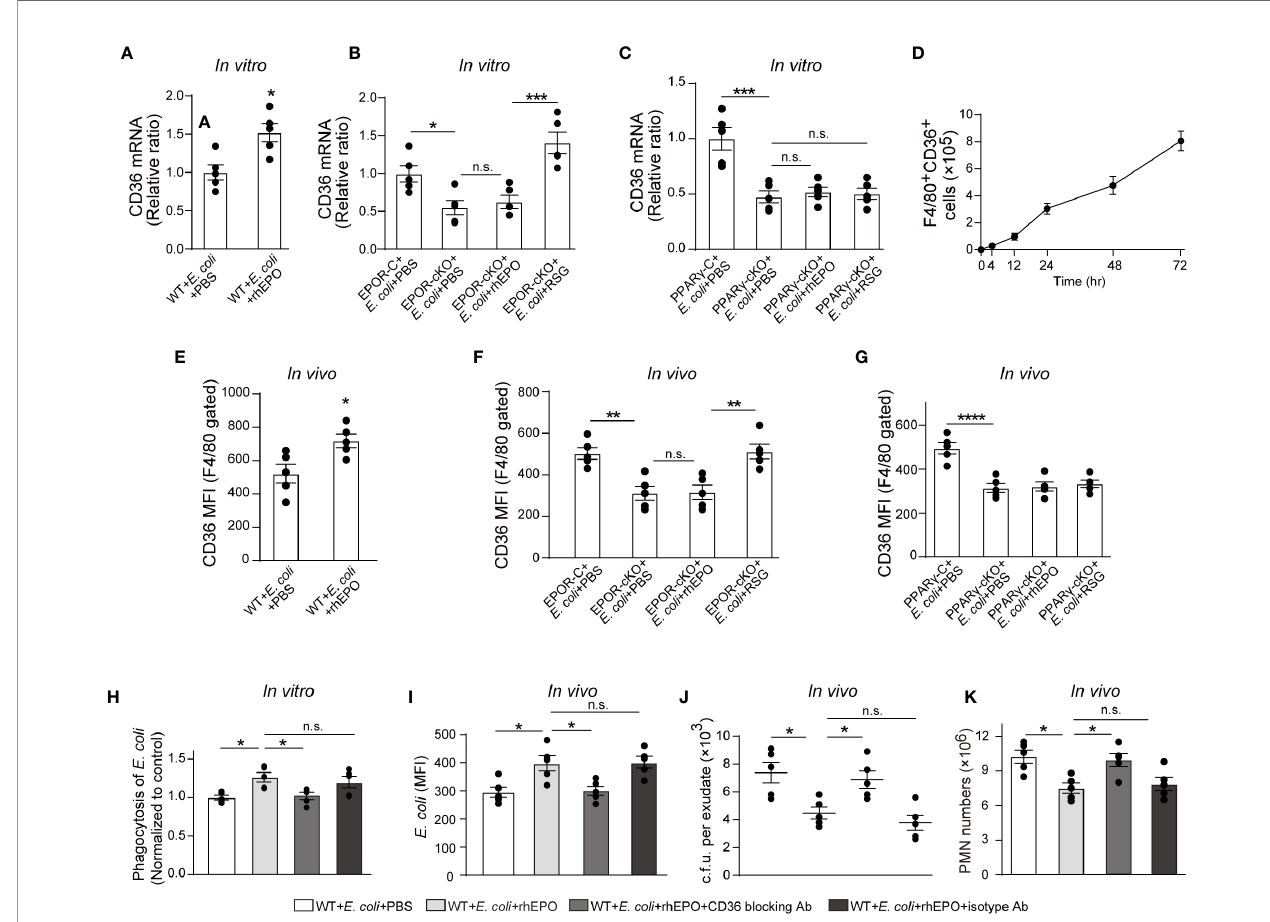
FIGURE 5 | PPAR g -induced CD36 contributes to EPO-enhanced macrophage phagocytosis of E. coli . (A) : Thioglycolate-elicited peritoneal macrophages were incubated with rhEPO (20 IU/ml) or PBS in the presence of heat deactivated E. coli (macrophage: E. coli = 1: 10) for 24 hrs. CD36 transcript levels in puri fi ed macrophages were assayed by RT-qPCR (n = 5). (B, C) : Thioglycolate-elicited peritoneal macrophages from EPOR-cKO mice (B) or PPAR g -cKO mice (C) were incubated with rhEPO (20 IU/ml, 24 hrs), RSG (10 m M, 48 hrs) or PBS in the presence of heat deactivated E. coli (macrophage: E. coli = 1: 10, 24 hrs) and then macrophage expression of CD36 mRNA was detected (n = 5). (D) : WT mice were inoculated with B coli at 1 × 10 5 c.f.u., F4/80 + CD36 + peritoneal macrophages were assayed by fl ow cytometry (n = 5). (E – G) : WT mice (E) , EPOR-cKO mice (F) or PPAR g -cKO mice (G) were inoculated with E. coli at 10 5 c.f.u. together with rhEPO (5,000 IU/kg), RSG (pretreated by 10 mg/kg, i.g. for 5 days) or PBS for 24 hrs and then peritoneal macrophages CD36 expression were assayed by fl ow cytometry (n = 5). (H) : Thioglycolate-elicited peritoneal macrophages from WT mice were treated with rhEPO (20 IU/ml), anti-CD36 blocking antibody (1 m g per million cells), isotype-control antibody (1 m g per million cells) or PBS for 24 hrs and then cells were collected and incubated with fl uorescently labeled E. coli (macrophage: E. coli = 1: 10) for phagocytosis assay (n = 5). (I – K) : WT mice were inoculated with E. coli at 10 5 c.f.u. together with rhEPO (5,000 IU/kg), anti-CD36 blocking antibody (3.3 mg/kg), isotype-control antibody (3.3 mg/kg) or PBS for 24 hrs. Intracellular E. coli levels in macrophages (I) , bacterial titers in peritoneal lavage fl uids (J) , numbers of peritoneal PMN cells (K) were measured (n = 5). Data are representative of at least two independent experiments. Results were expressed as mean ± SEM. ns, not statistically signi fi cant. * P < 0.05, ** P < 0.01, *** P < 0.001, **** P < 0.0001. Statistics: unpaired two-tailed Student ’ s t-test (A, E) or one-way ANOVA with Tukey ’ s post hoc test for multiple comparisons (B, C, F – K)